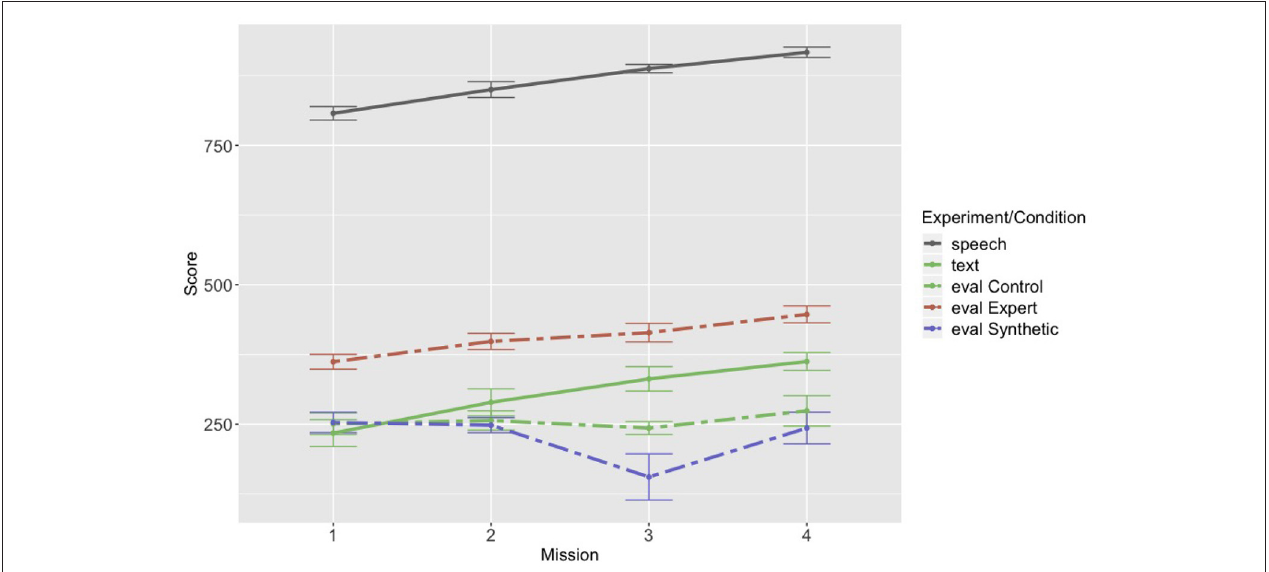
FIGURE 8 | Performance across the first four missions for each of the text and speech experiments and the evaluation experiment conditions: control, expert, and